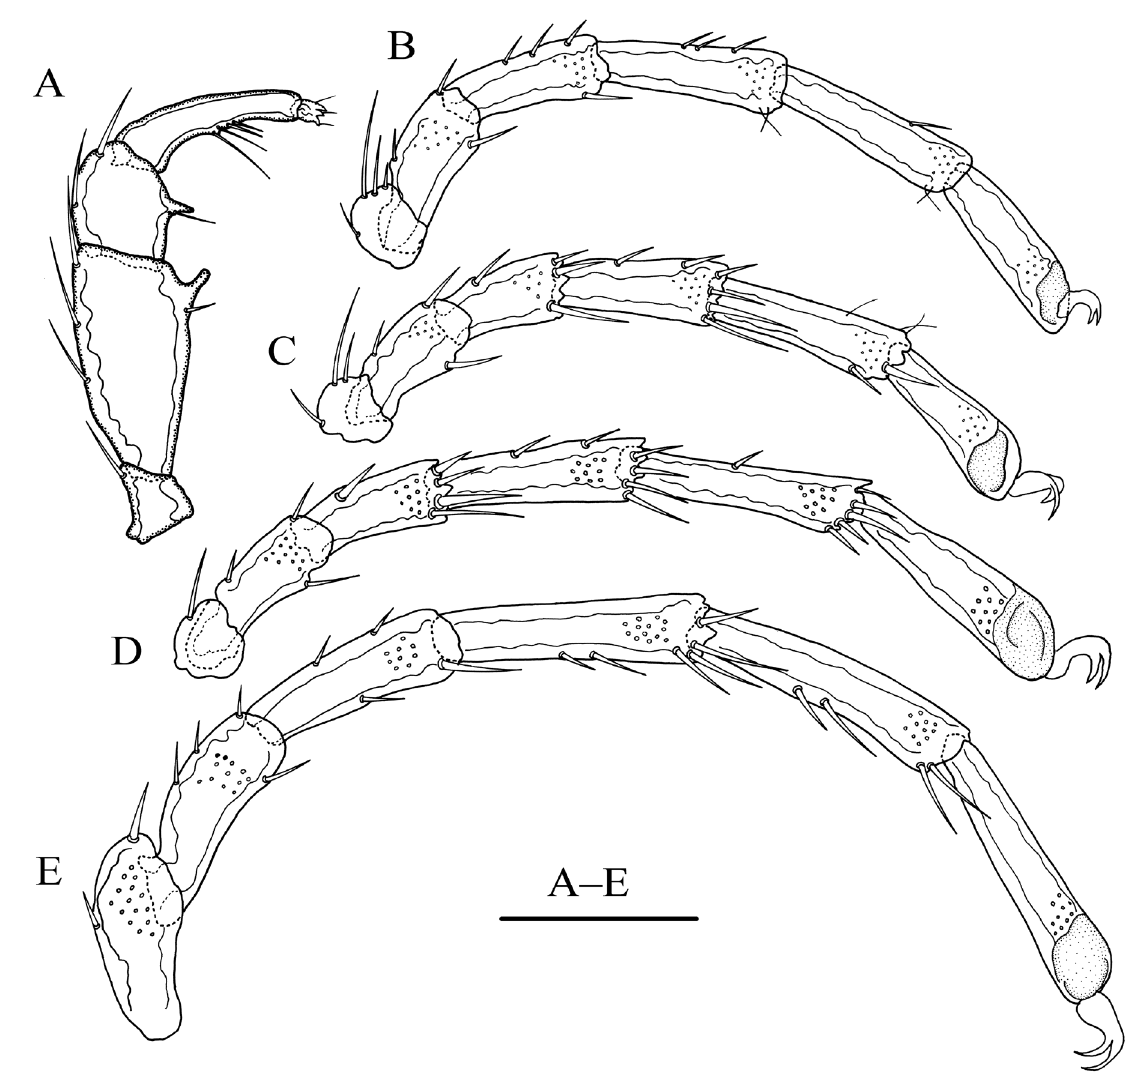
Fig. 4. Torrenticola suptilisrostrum Gu & Guo sp. nov., ♀, paratype ( FJ-TO-20180803) . A . Palp, lateral view. B . leg-I. C . leg-II. D . leg-III. E . leg-IV. Scale bar = 100